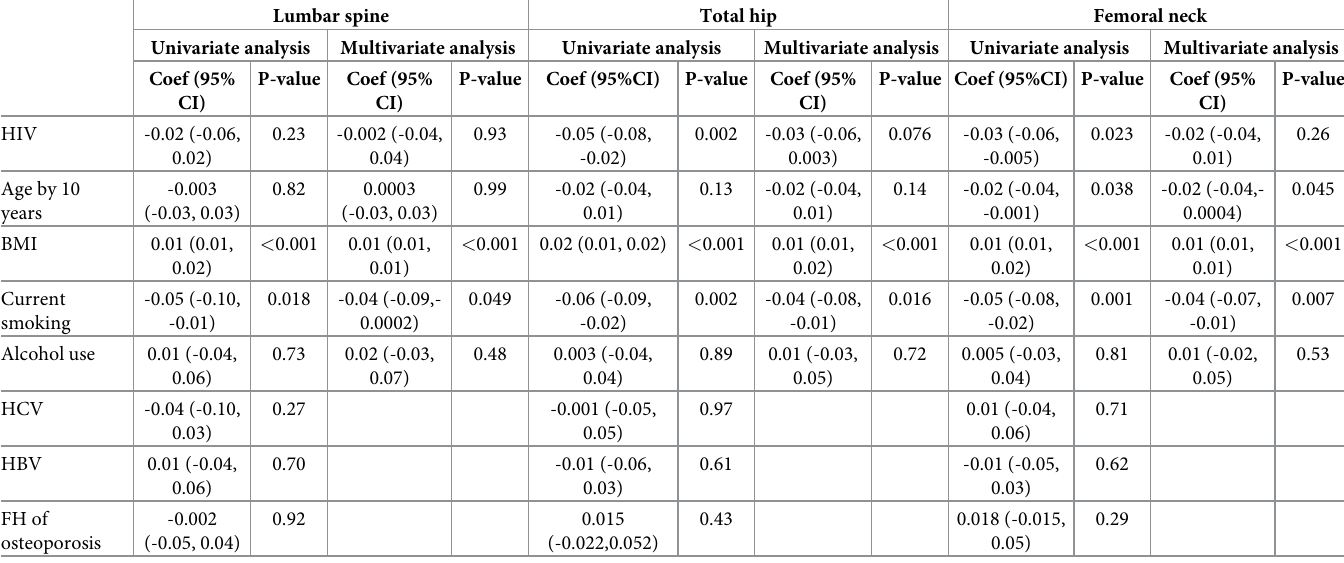
Table 3. Univariate and multivariate analysis of factors associated with BMD at the lumbar spine, total hip, and femoral neck in